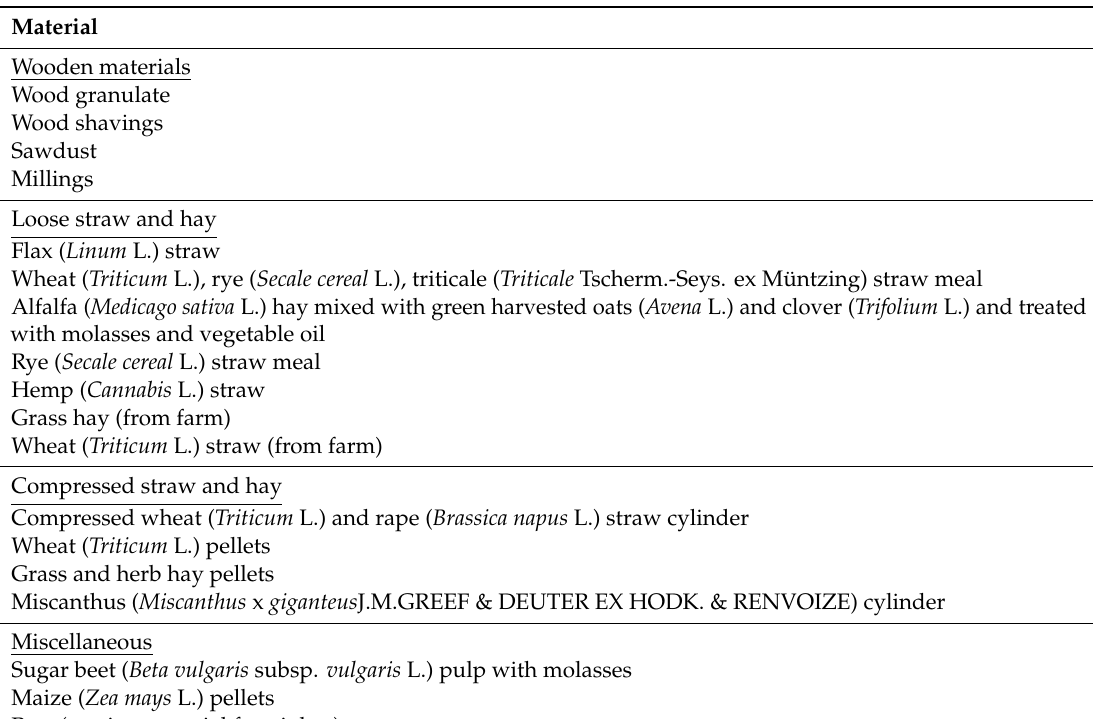
Table 2. Organic enrichment materials considered in the